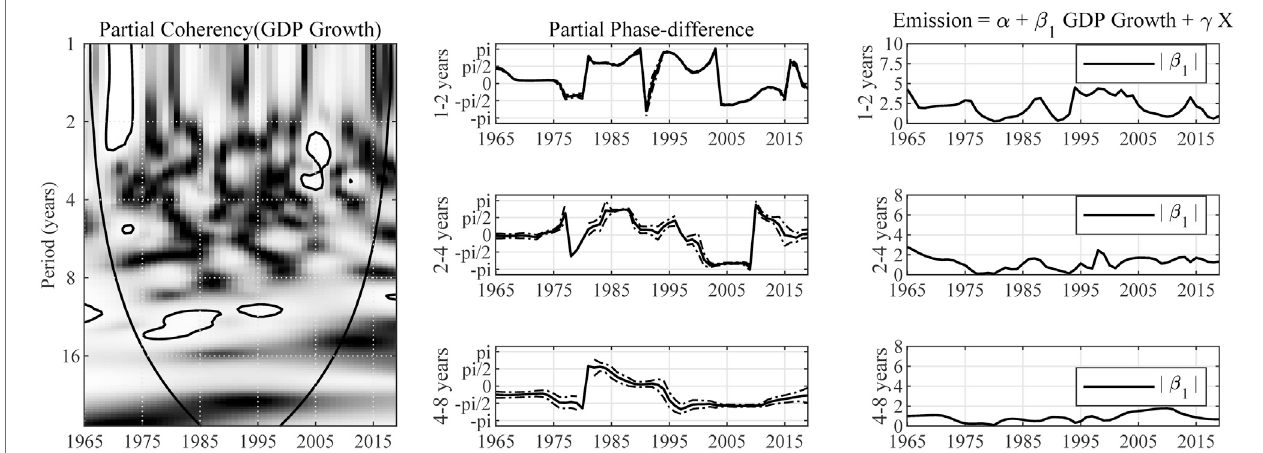
FIGURE 3 | Impact of GDP growth on carbon emission in China. Note: The expression “ Partial Coherency (GDP Growth) ” denotes the partial coherency between GDP growth and carbon emission, controlled for the in fl uence from energy structure and trade openness. The areas below the symmetric black convex curve that appears in the fi gure of coherency are called the “ Cone of In fl uence (COI), ” in which the edge effects are profound. Inside the COI, the results tend to be unreliable. The contoursinthecoherencydiagramsindicate5%signi fi cancelevel,bootstrappedfor10,000replications.And,thebrightercolorscorrespondtohighersigni fi cance level, and darker colors correspond to lower signi fi cance level. The dotted lines accompanying the partial phase-difference indicate the 95% con fi dence intervals.